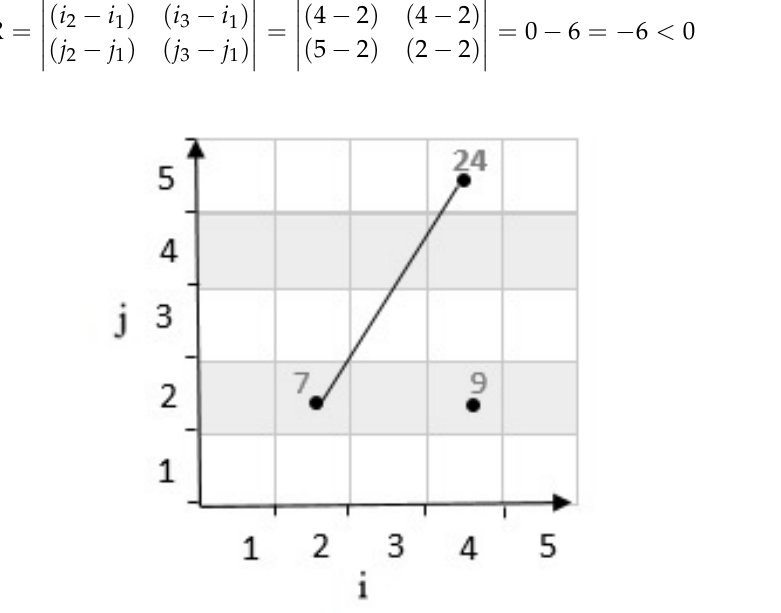
Figure 6. Position of a point with negative